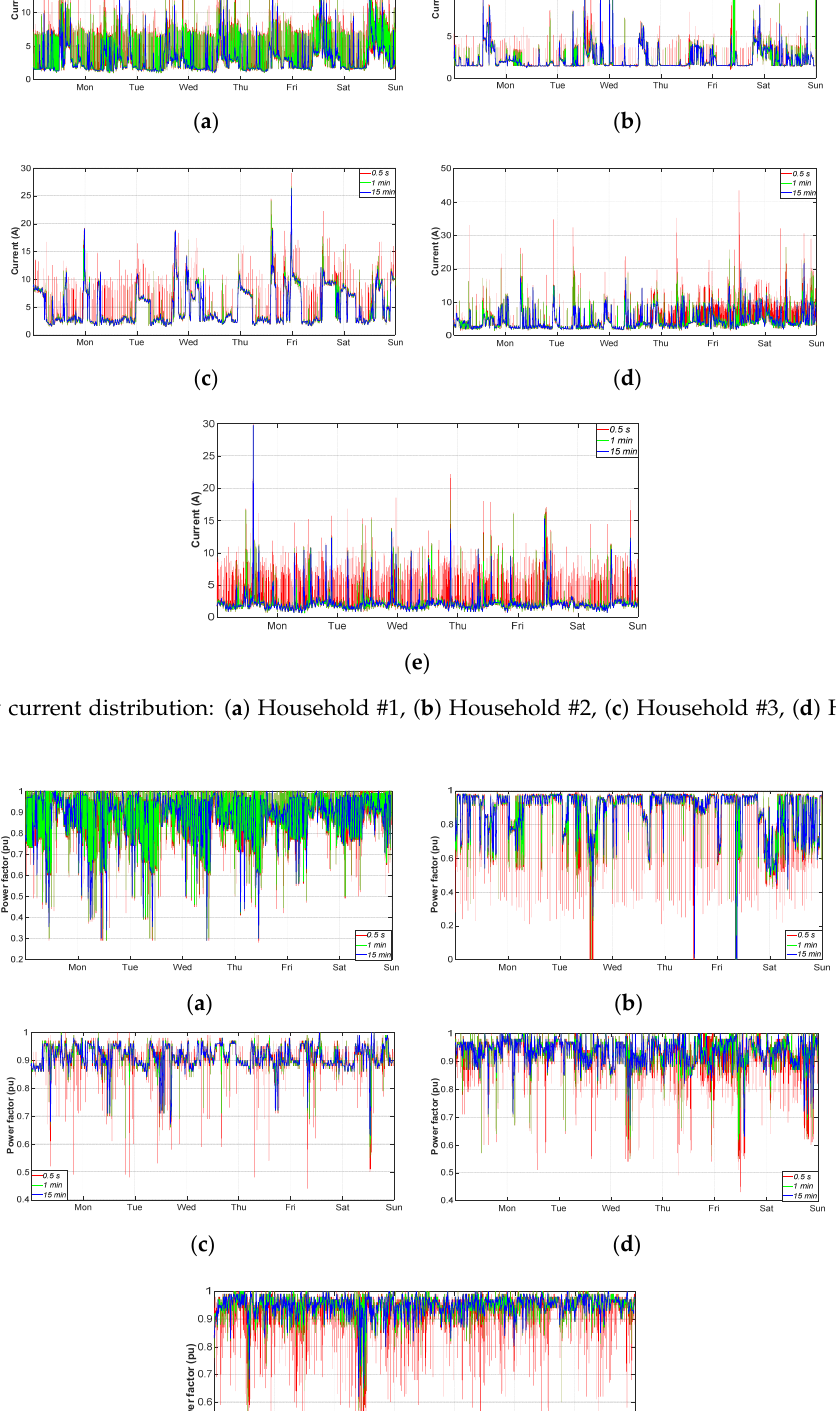
Figure 11. Weekly voltage distribution: ( a ) Household #1, ( b ) Household #2, ( c ) Household #3, ( d ) Household #4 and ( e ) Household #5.